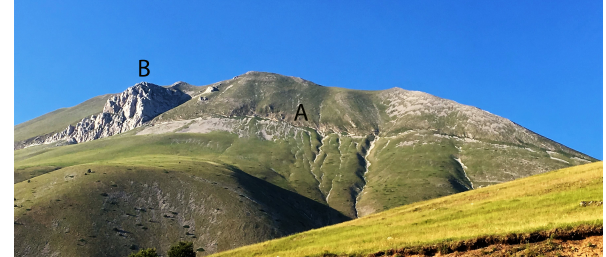
Figure 12. Vettore Massif (2476m) with a view from south to west, showing the fault (A – Corniola formation) at the base of L’Aquila rock (B – Calcare Massiccio